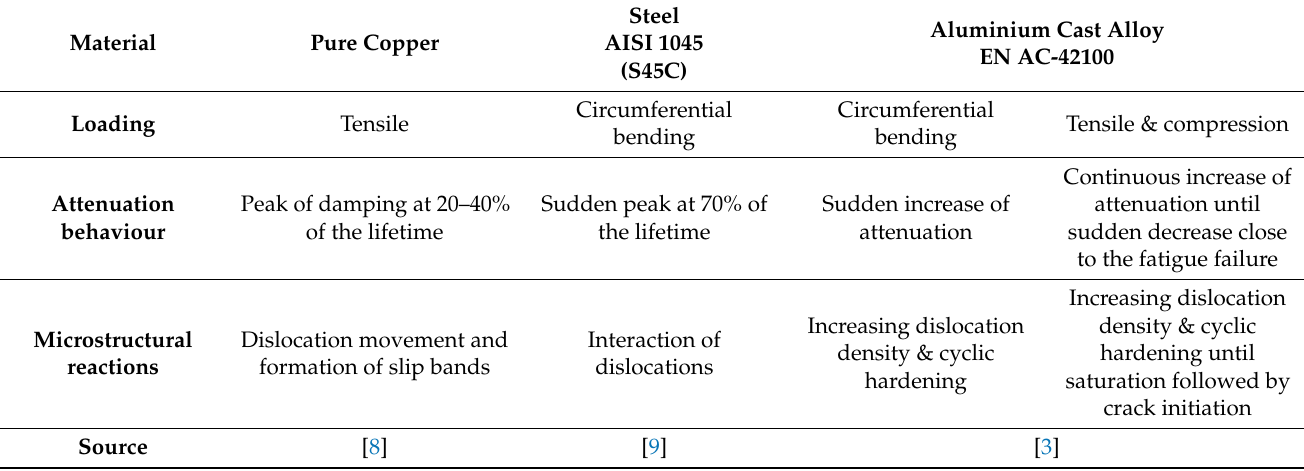
Table 1. Materials’ reactions on cyclic loading with respect to attenuation.